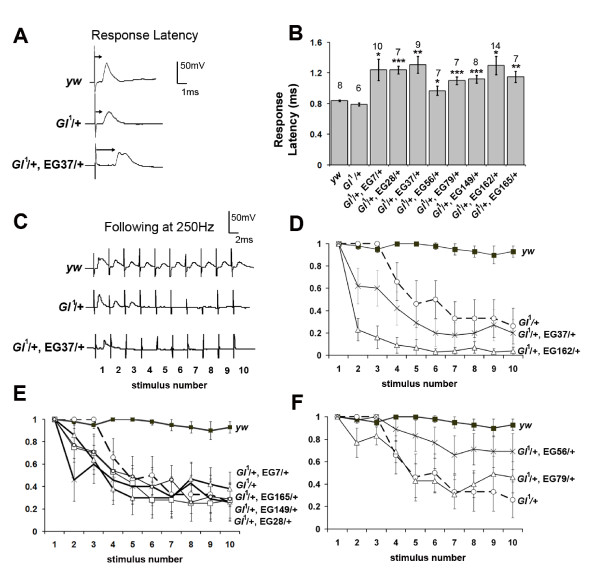
Mutations that enhance the electrophysiological phenotype seen in Gl1/+ adult flies. (A) Traces from individual flies showing the response latency upon a single stimulus. Both yw controls and Gl1/+ flies show short response latencies. The addition of EG37/+ into the Gl1 background causes an increase in the latency. (B) Histograms showing the average response latencies recorded for all enhancers in the Gl1 background. The number of preparations tested (n) is given above each bar and latencies for flies containing Gl1/+ plus enhancers compared to flies containing Gl1/+ alone. *P < 0.05, **P < 0.01, ***P < 0.001 in unpaired Student's t-test. (C) Traces from individual flies showing following to 10 stimuli at 250 Hz. yw controls usually gave a response to each stimulus (1-10) whereas this was depressed in Gl1/+ individuals which often gave a response to stimuli 1-3 and then failed to respond to the remaining 7 stimuli. The addition of EG37/+ enhances this effect. (D-F) Graphs showing the average probability of a response for stimuli 1 through 10 at 250 Hz. The data for yw and Gl1/+ flies is shown in each panel for comparison against flies trans-heterozygous for Gl1/+ and the various enhancers. Enhancers EG37/+ and EG162/+ seemed to increase the depression seen in Gl1/+ flies with a decrease in the probability of obtaining a response with subsequent stimuli (D). Other enhancers either had no effect (E) or slightly increased the probability of a response from the late (7-10) stimuli (F).